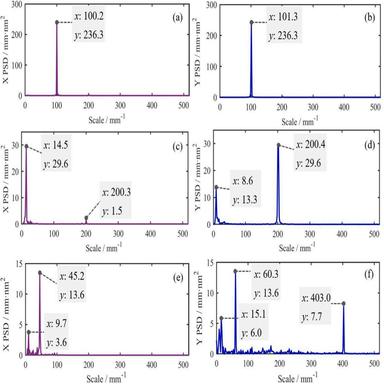
PSD analysis of (a, d, and g) at the machining conditions of: I - (a) along the step direction X and (b) along the feed direction Y, II - (c) along the step direction X and (d) along the feed direction Y, and III - (e) along the step direction X and (f) along the feed direction Y.